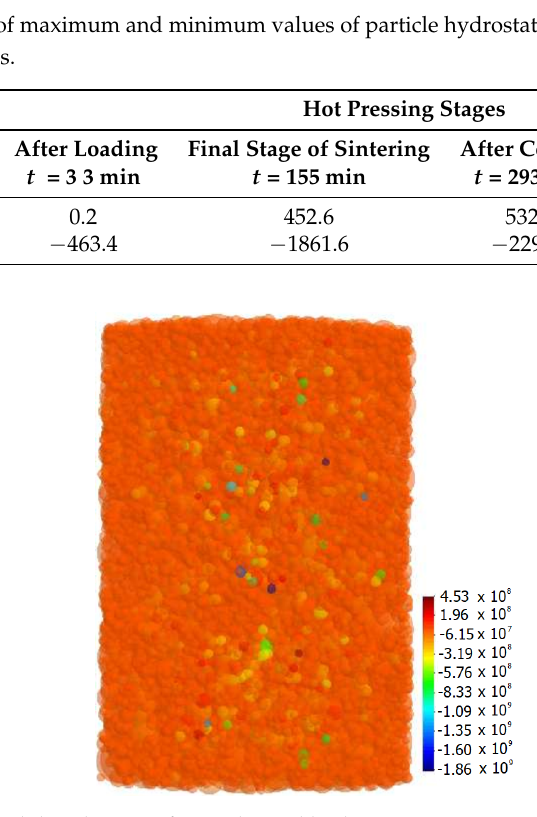
Figure 15. Graphical distribution of particle total hydrostatic stresses in the final stage of